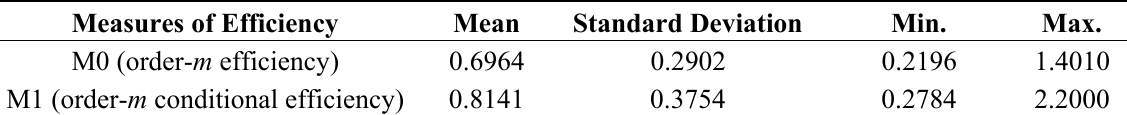
Table 3. Levels of mean efficiency for WWTPs.